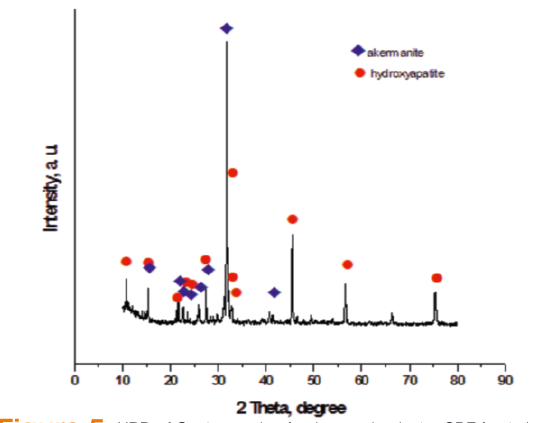
Figure 6. XRD of Ca-2 sample after immersion in 1.5 SBF for 1 day Figure 8. SEM of the Ca-2 sample after thermal treatment at 1200°C/2 h